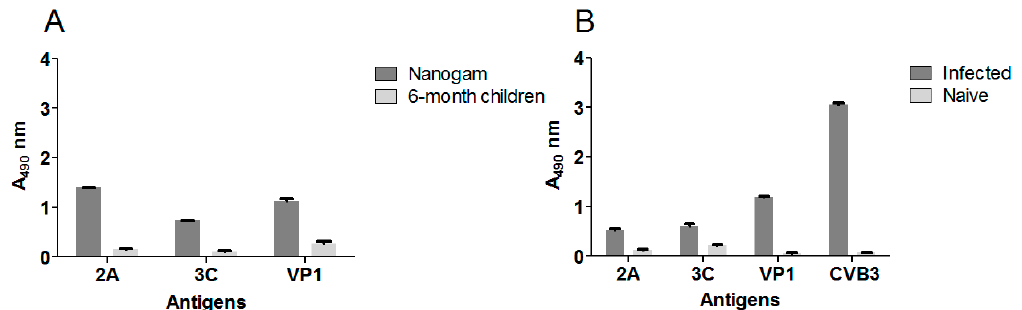
Figure 2. Antibody reactivity towards enterovirus structural and non-structural proteins in serum from 6-month old children, adults and CVB infected mice. ( A ) 2A, 3C, and CVB3 VP1 antibodies in sera pooled from 6 month-old humans (1:1000 dilution, white) and from Nanogam ® serum (1:10,000 dilution, gray bars) and ( B ) 2A, 3C, VP1, and CVB3 antibodies in pooled naïve (white bars) and CVB3 infected (21 dpi; grey bars) mouse sera (both 1:1000 dilution) as detected by ELISA. Each bar represents a pool of sera ( n = 20 for humans, n = 18 for infected mice and n = 4 for naïve mice). Data is presented as means ± S.E.M.